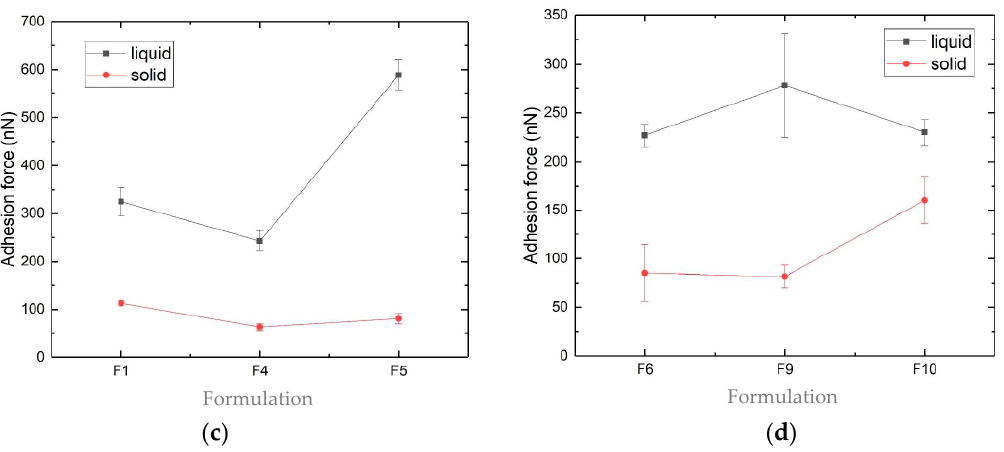
Figure 9. Average adhesion forces measured by the atomic force microscopy (AFM) of the SLM placebo and with the API formulations prepared “de novo” ( ■ liquid) and after spray drying ( ● solid) with Compritol: ( a ) and ( c ) or with stearic acid: ( b ) and ( d ).